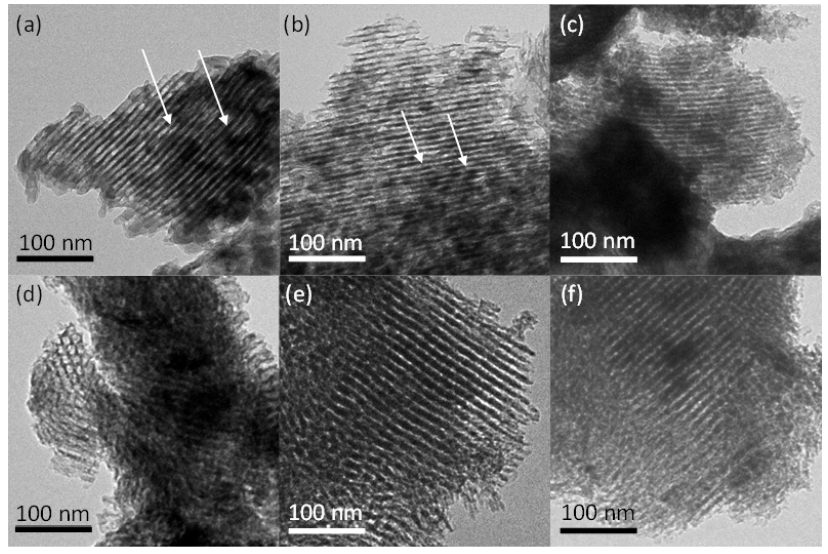
Figure 3. TEM micrographs of Al 2 O 3 _A_400 ( a ), Al 2 O 3 _A_900 ( b ), CZZ@Al 2 O 3 _A ( c ), Al 2 O 3 _B_400 ( d ), Al 2 O 3 _B_900 ( e ), and CZZ@Al 2 O 3 _B ( f